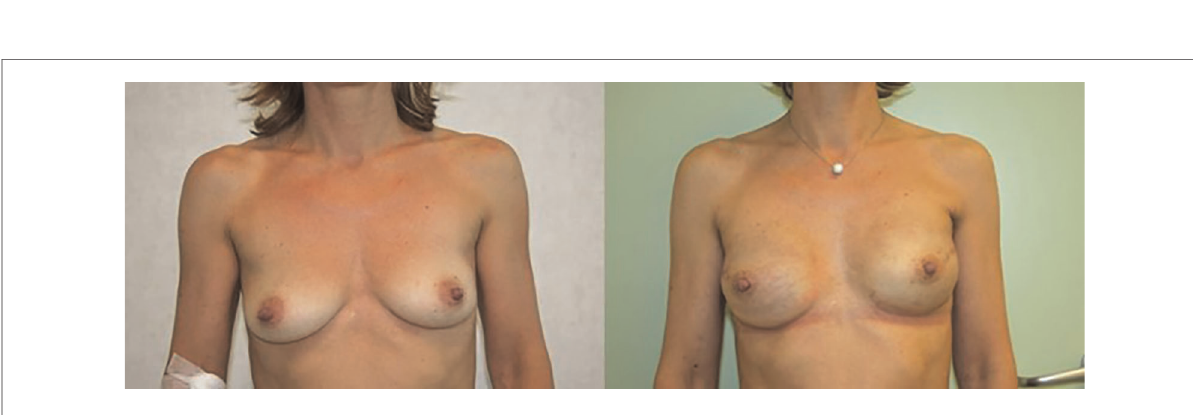
FIGURE 2 IBR with prepectoral implantation, preceded bilateral nipple-sparing mastectomy. Pre- (left) and post- operative photos